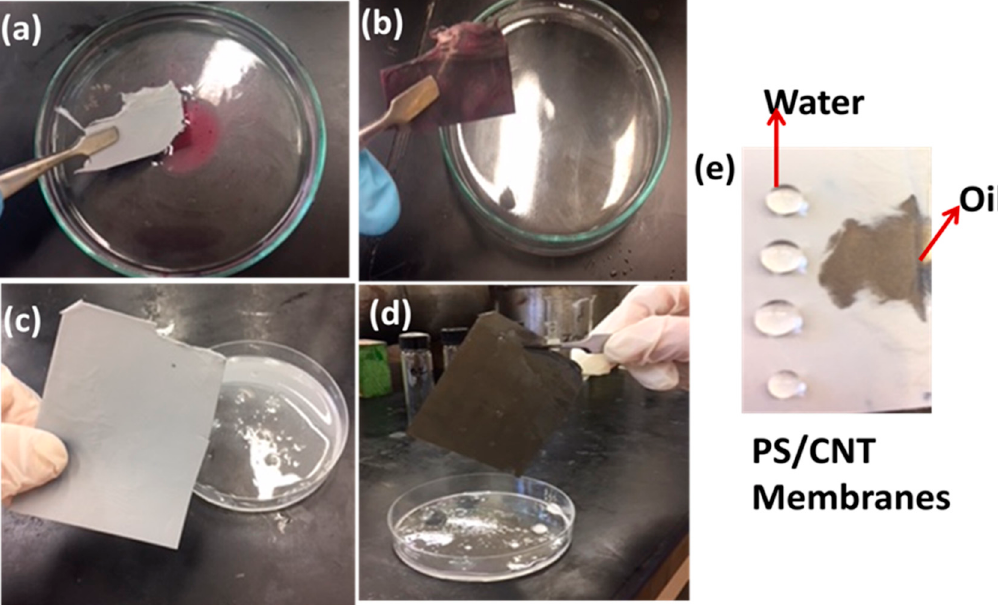
Figure 6. ( a–d ) Oil absorption capacity of dyed hydraulic oil from its mixture with water, ( e ) snapshot showing oil and water droplets on the PS/CNT membrane.